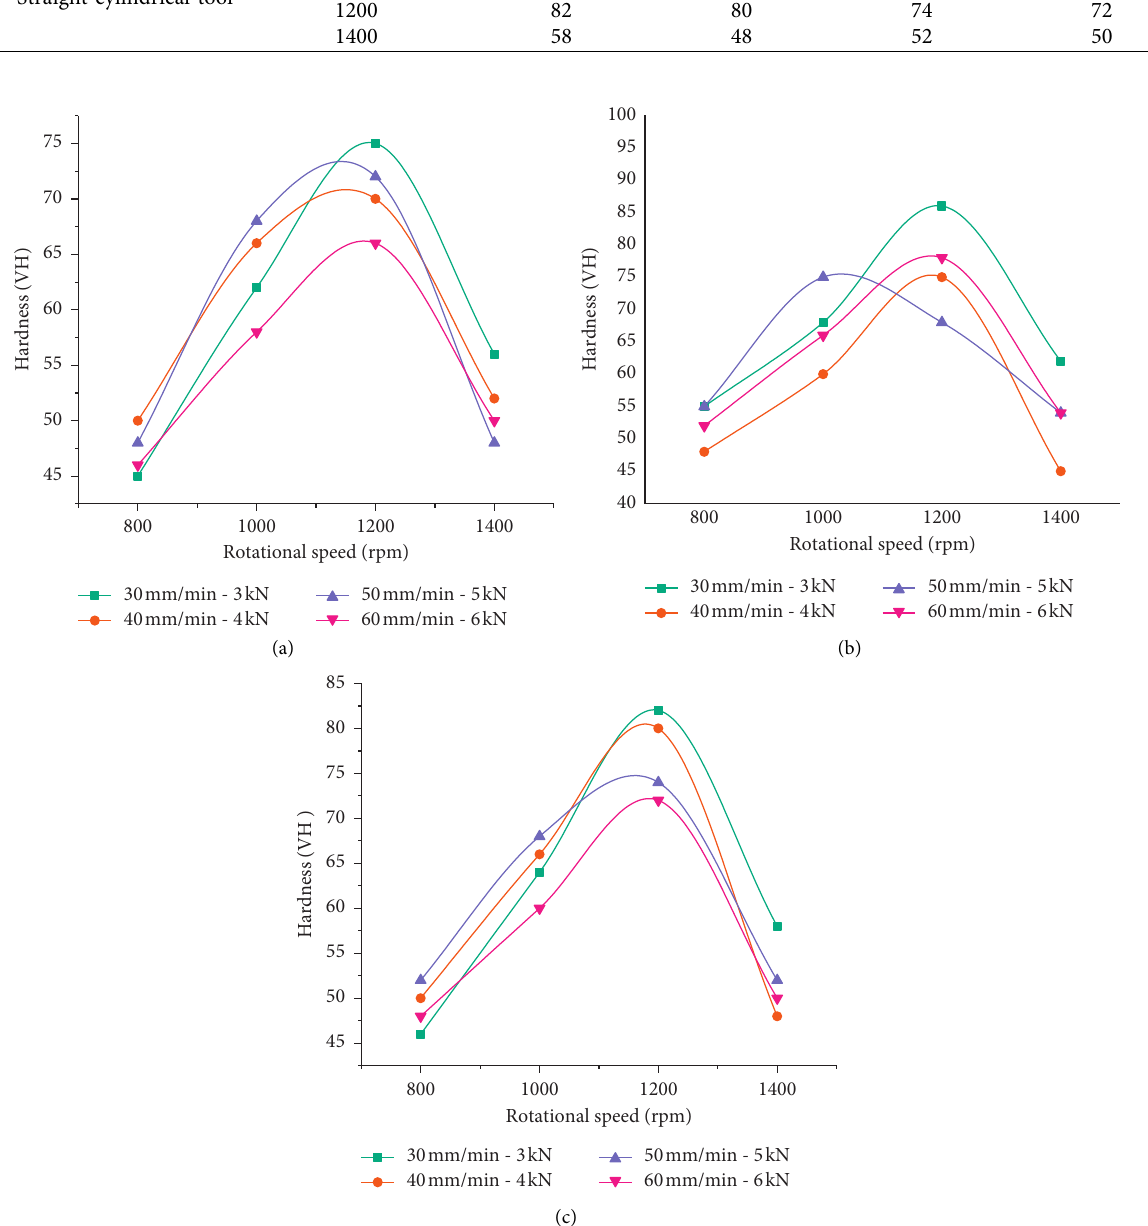
Figure 3: (a) Rotational speed vs. hardness (cylindrical taper tool), (b) Rotational speed vs. hardness (triangular tool), and (c) Rotational speed vs. hardness (straight cylindrical